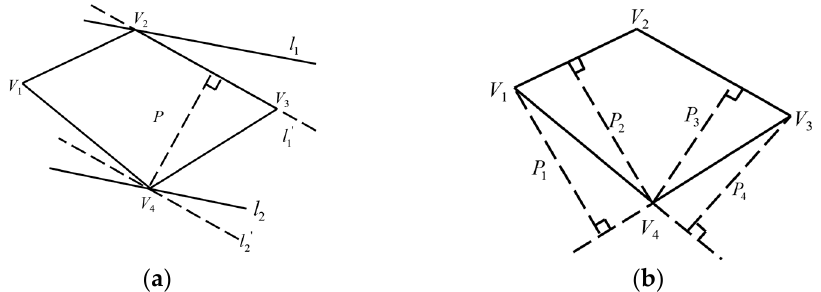
Figure 9. Method to determine the minimum width of convex polygon. ( a ) Rotary caliper method; ( b ) vertex perpendicular method.